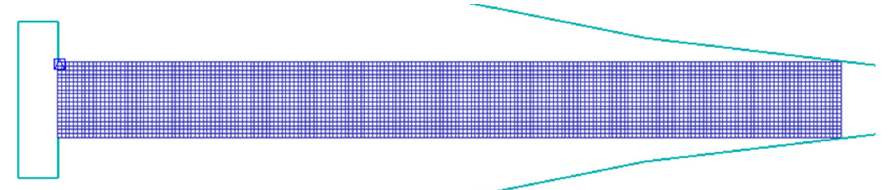
Figure 3. Geometry of the roll ‐ gap, used for FEM simulation.